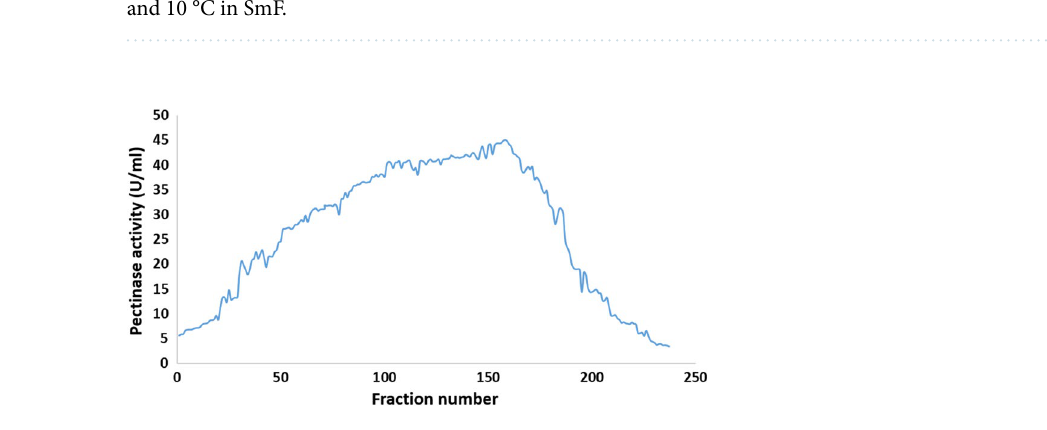
Figure 15. Purification of pectinase by size exclusion chromatography using Sephadex G-100.